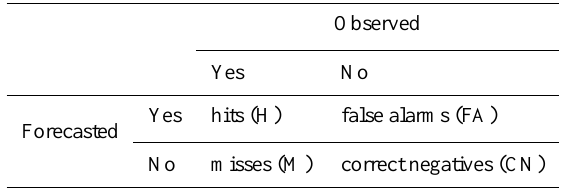
Table 4. Contingency table for flood